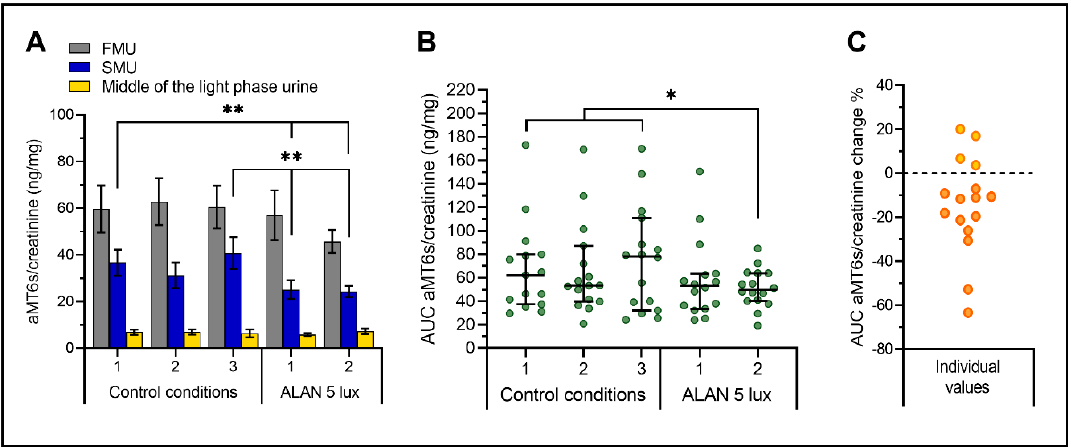
Figure 1. Mean aMT6s / creatinine concentrations ( A ), AUC of aMT6s / creatinine ( B ), and percent of individual aMT6s / creatinine change ( C ) in healthy volunteers ( n = 16) after three control nights (sleeping in a dark room) and ALAN 5 lux (exposure up to 5 lux during the entire two nights). FMU—first-morning urine, SMU—second-morning urine, urine in the middle of the day collected between 12:00–15:00 hrs, AUC—area under the curve. ** p < 0.01, * p < 0.05 (ANOVA for repeated measurements with Fisher LSD multiple comparison test). ( A ) The bars represent mean ± SEM, ( B ) Dot plot representing individual AUC values calculated from three urine samples of each individual and median with 95% CI, ( C ) Individual dot plots represent changes in AUC after ALAN exposure, negative values indicating aMT6s/creatinine reduction.